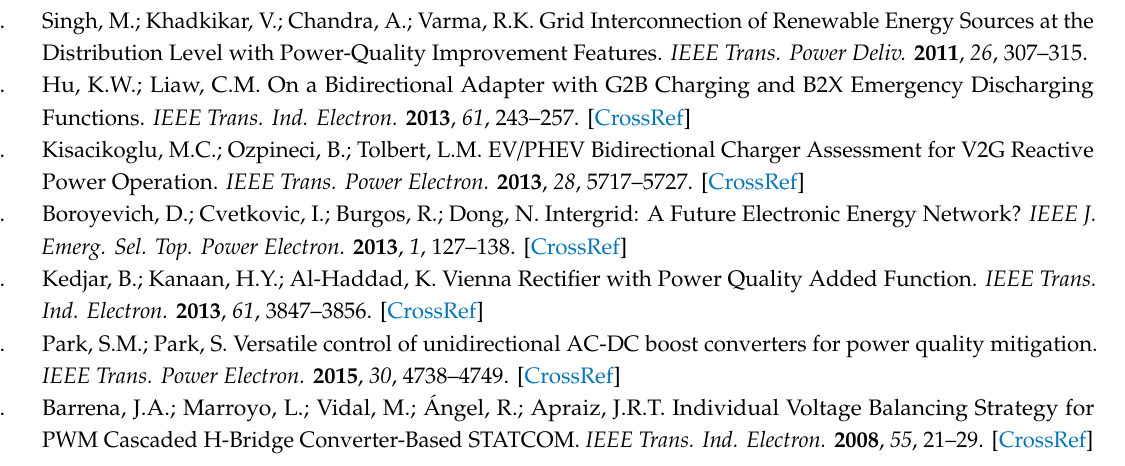
Figure 11. Waveforms of DC-bus voltage for each bridgeless modules and H-bridge modules. ( a ) Voltage balance control is not activated; ( b ) voltage balance control is activated.